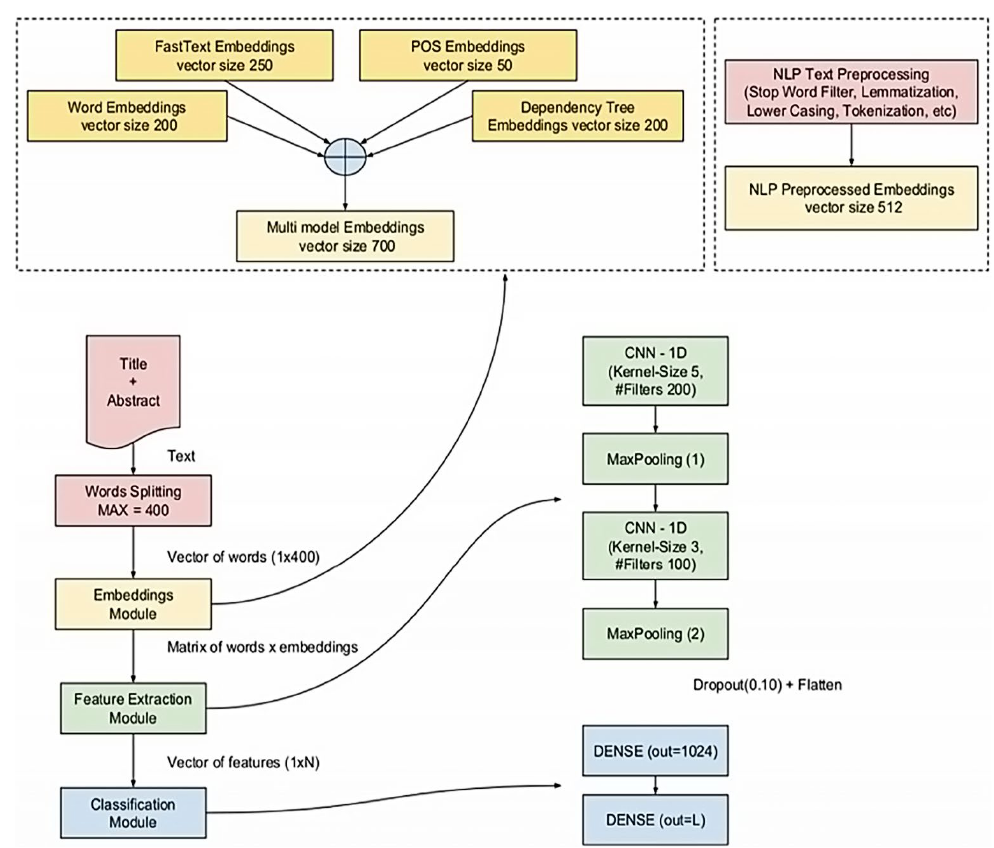
Figure 2. Graphical representation of the DNN models used by Gargiulo et al.